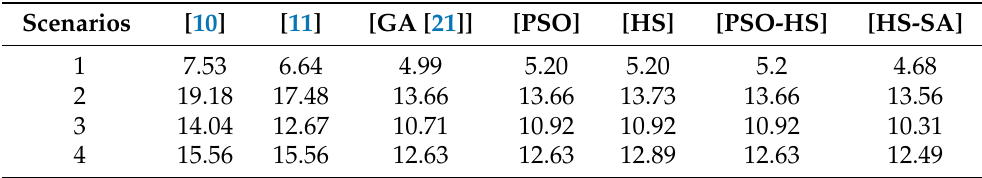
Table 2. Comparative performance of different techniques.